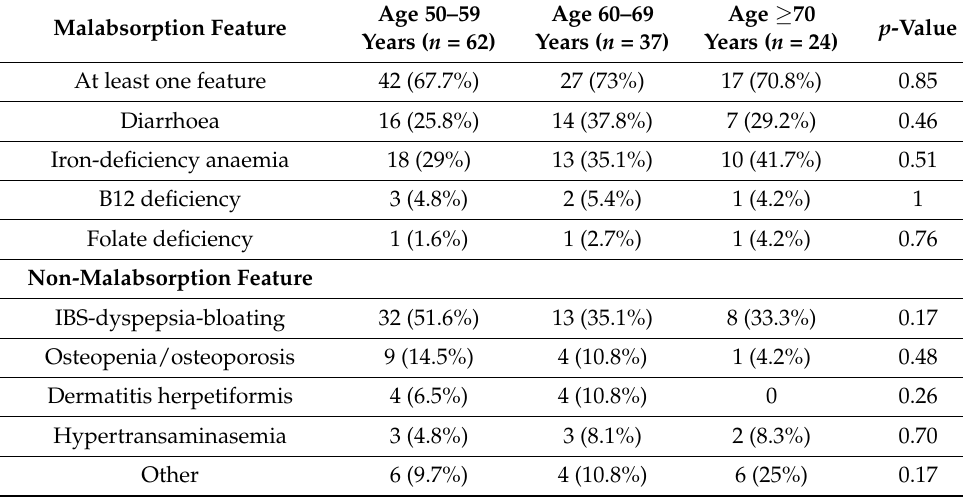
Table 1. Association between malabsorption features at presentation and age at CD diagnosis.